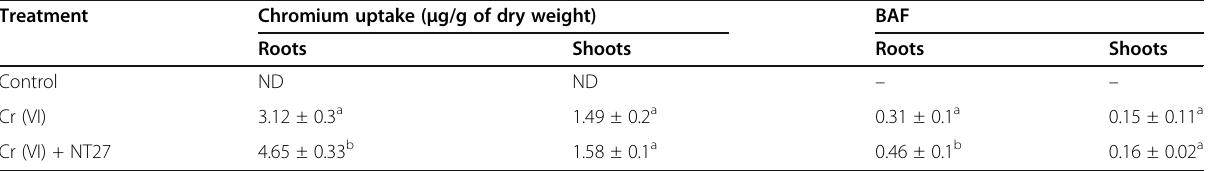
Table 3 Effect of Pseudomonas sp. (NT27) on Cr content ( μ g/g) and bioaccumulation factor (BAF) of the shoots and roots of alfalfa grown on contaminated soils with Cr (VI). Values with different letters are significantly different ( p <